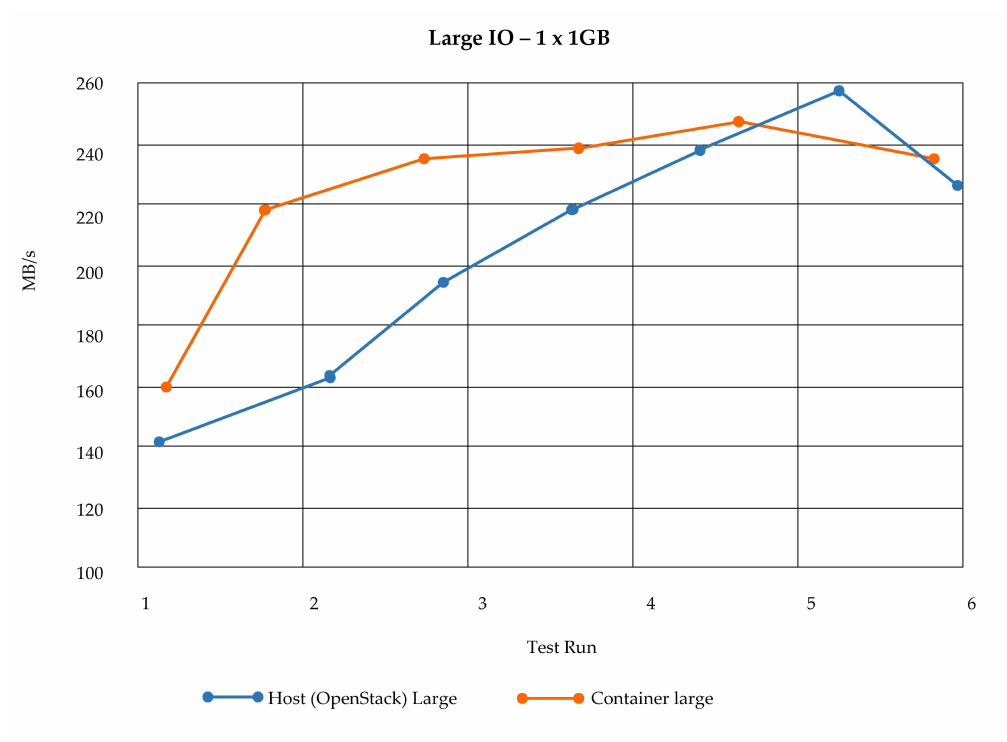
Figure 28. Container usage in Large Host